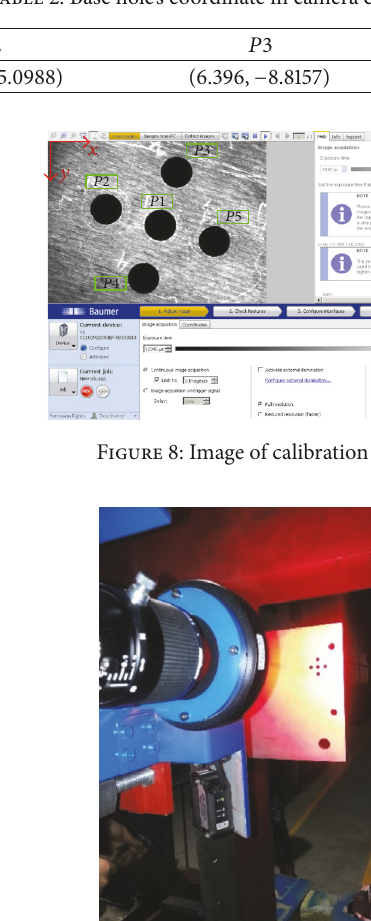
Table 2: Base hole’s coordinate in camera coordinate system.